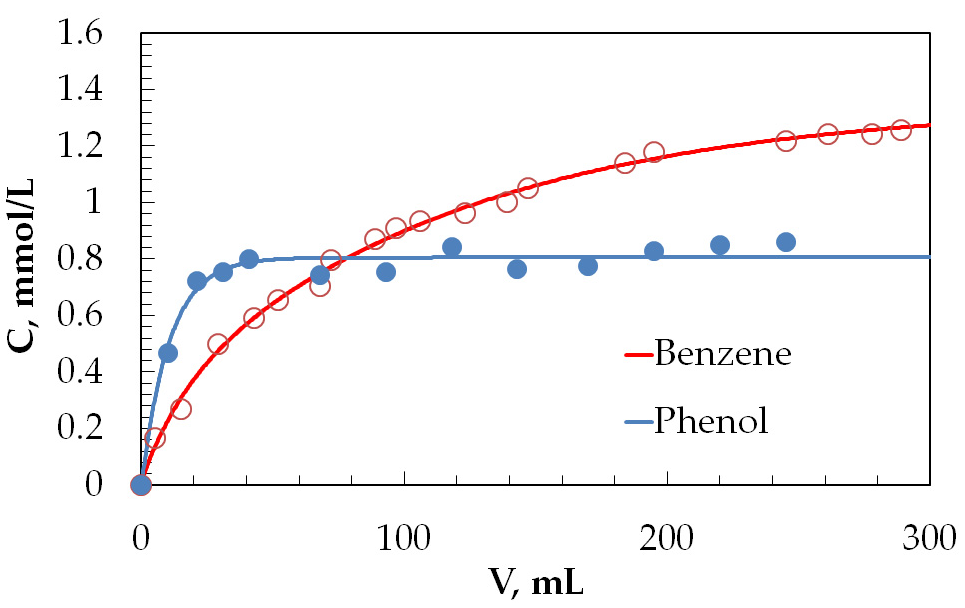
neutral pH (Figure 17).